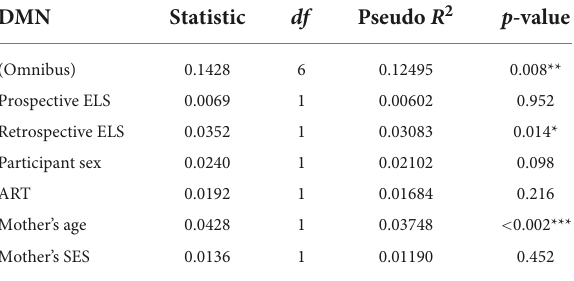
TABLE 3 Multivariate distance matrix regression (MDMR) analysis results for the default mode network (DMN), with prospective ELS and retrospective ELS as independent variables, and participant sex, ART, mother’s age and mother’s SES as covariates.